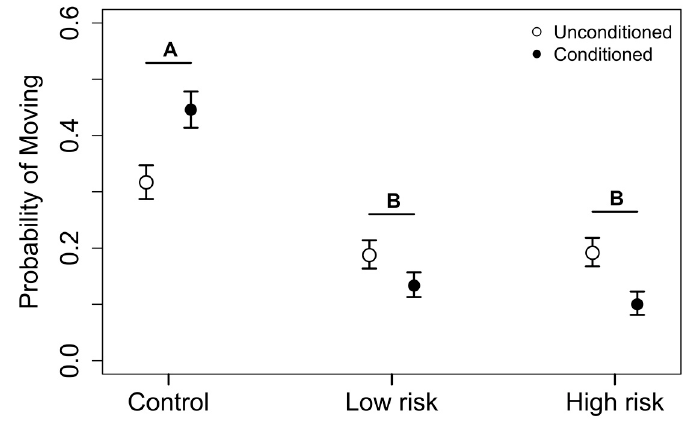
Figure 3. The probability of moving within respirometer chambers during exposure to varying levels of risk/kairomone concentrations. Activity was measured as proportion of time turning, rocking the body, or moving the tail during the 30 min exposure trial. Conditioned hellbenders increased their probability of moving when exposed to water without kairomones, but had a lower probability of moving when they were presented with low and high concentrations of predator kairomones compared to unconditioned individuals ( p < 0.05). Estimates are back-transformed and presented with standard errors. There were significant differences between conditioned and unconditioned individuals at each of the three exposure levels. Letters indicate significant differences across exposure levels ( p < 0.05).